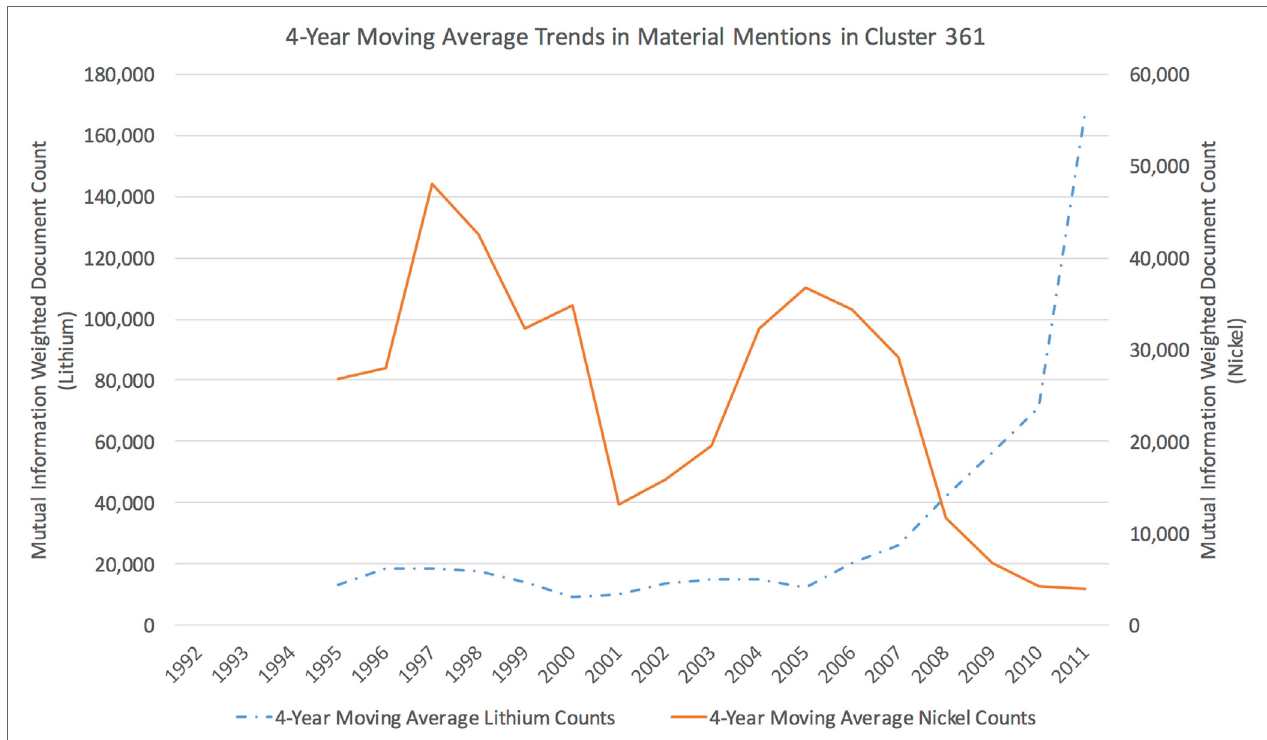
FigUre 11 | 4-year moving averages for lithium and nickel document counts in term cluster 361. These results from SRI algorithms show decreasing activity in battery research using nickel hydrides by 2008 while lithium research increased for battery